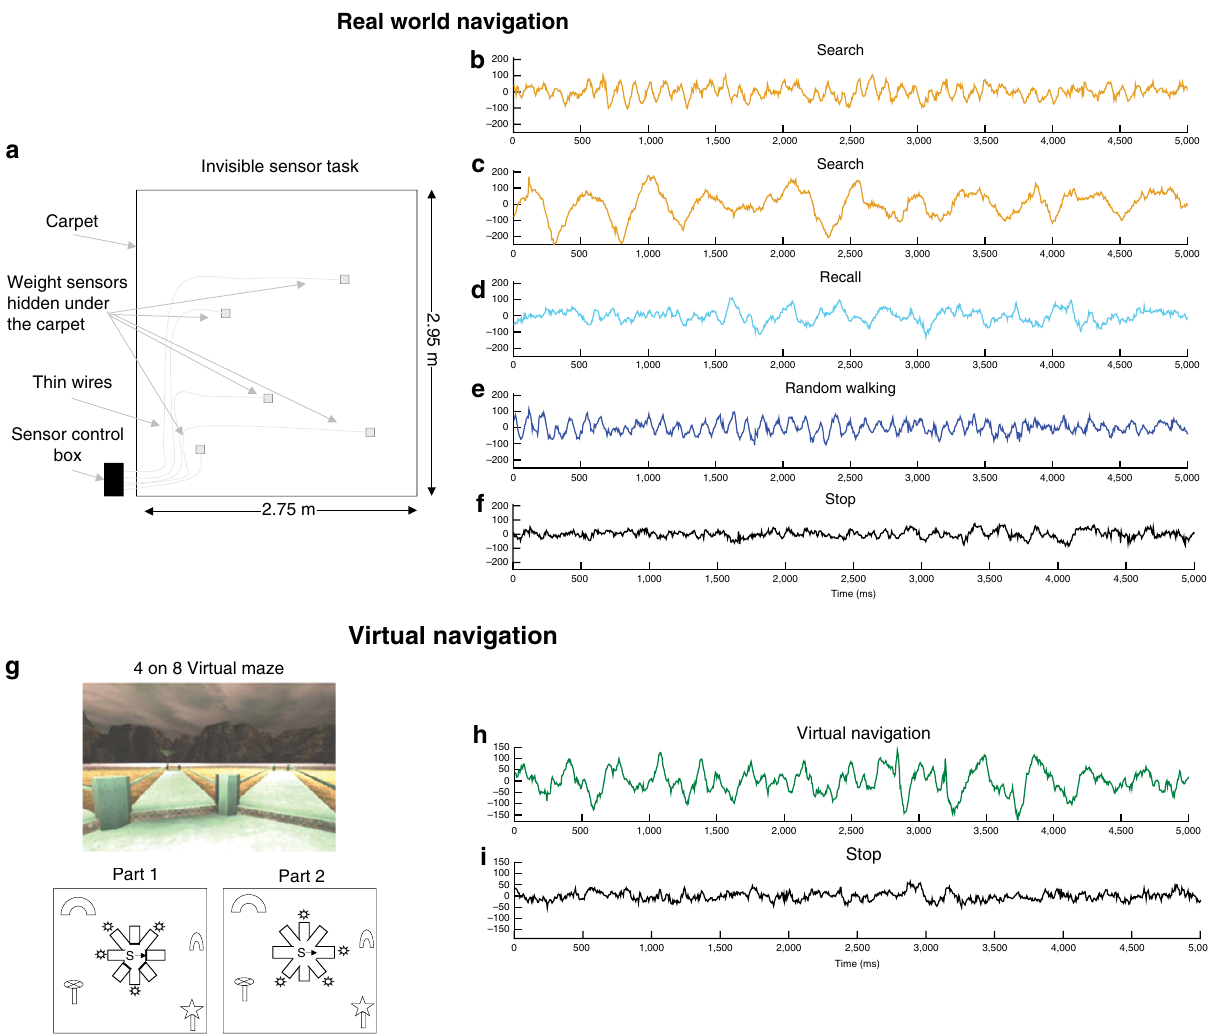
Figure 1 | Overview of behavioural tasks and 5-s traces from hippocampal contacts during real-world conditions. ( a ) Top view of the space patients navigated while searching for invisible sensors (thin square plate) underneath the carpet. ( g , top) First person view of the virtual navigation task showing landmarks in the distance as well as views of the radial arms in the task. ( g , bottom) Bird’s eye view of radial arms layout. Patients were instructed to search for target objects (denoted by the suns) at the bottom of a pit located at the end of the arm. In part 1, patients could only enter four arms to pick up the objects. In part 2, patients had to remember previously visited arms and avoid them in order to retrieve the target objects in the new arms. ( b ) Posterior hippocampal contact from patient #2 demonstrates high-theta oscillations during real-world search for the invisible sensors. ( c ) Hippocampal contact from patient #4 demonstrates low-theta oscillations during real-world search for an invisible sensor. ( d ) Hippocampal contact from patient #5 demonstrates low to mid-range theta oscillations during recall of spatial locations in the invisible sensor task. ( e ) Posterior hippocampal contact from patient #2 demonstrates theta oscillations during real-world random walking. ( f ) Hippocampal contact from patient #2 shows minimal oscillations when patient is stopped and standing still. ( h – i ) Five-second raw traces from hippocampal contacts during the VR task. ( h ) Hippocampal contact from patient #5 demonstrates low to mid-range theta oscillations during VR navigation. ( i ) Hippocampal contact from patient #2 shows minimal oscillations when patient is not